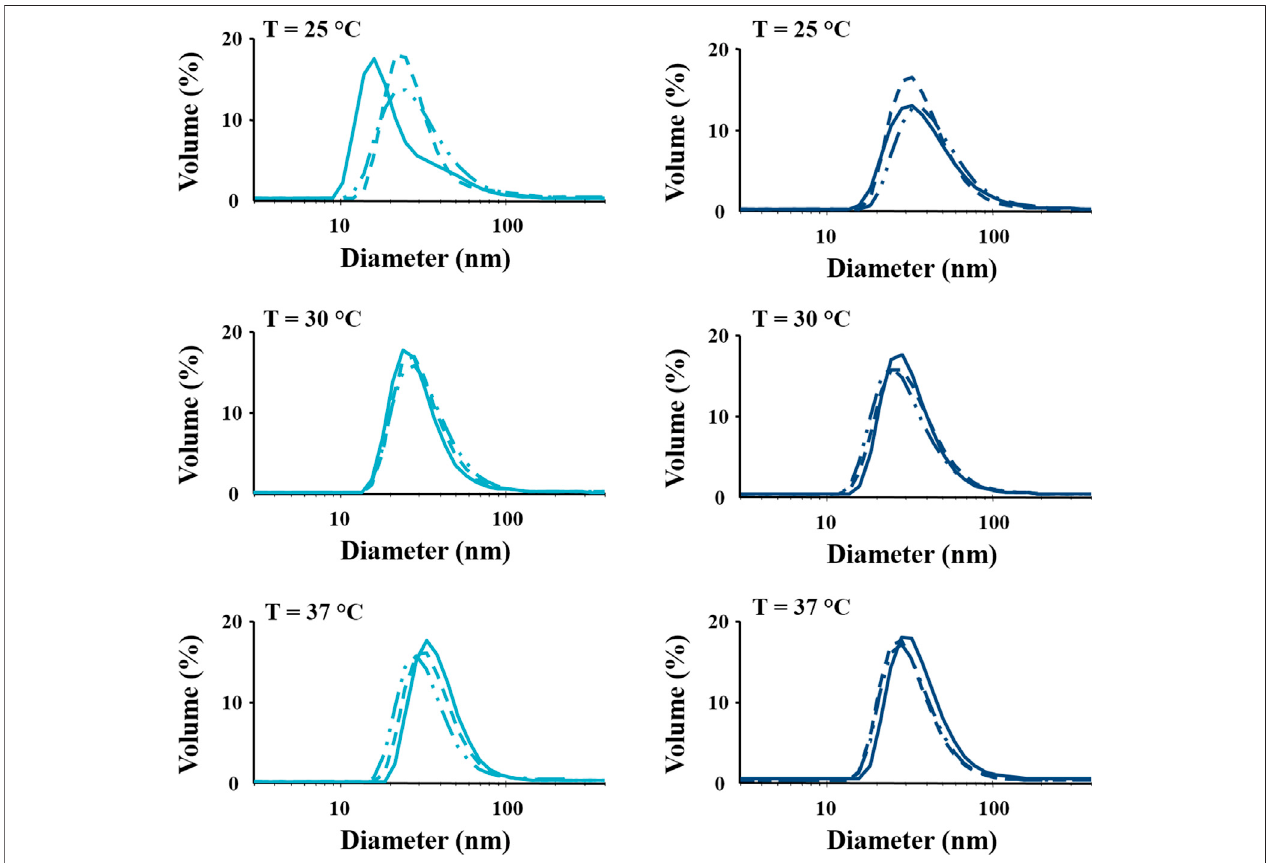
FIGURE4 | Distribution patterns (by volume) ofmicelle hydrodynamic diametermeasured inCHP407 (light blue) and CHP407_P(darkblue) solutions at 0.5% w/V concentration. Analyses were performed in triplicate (continuous, dashed and dashed-dotted lines represent the three registered patterns) at 25 ° C, 30 ° C and 37 ° C.